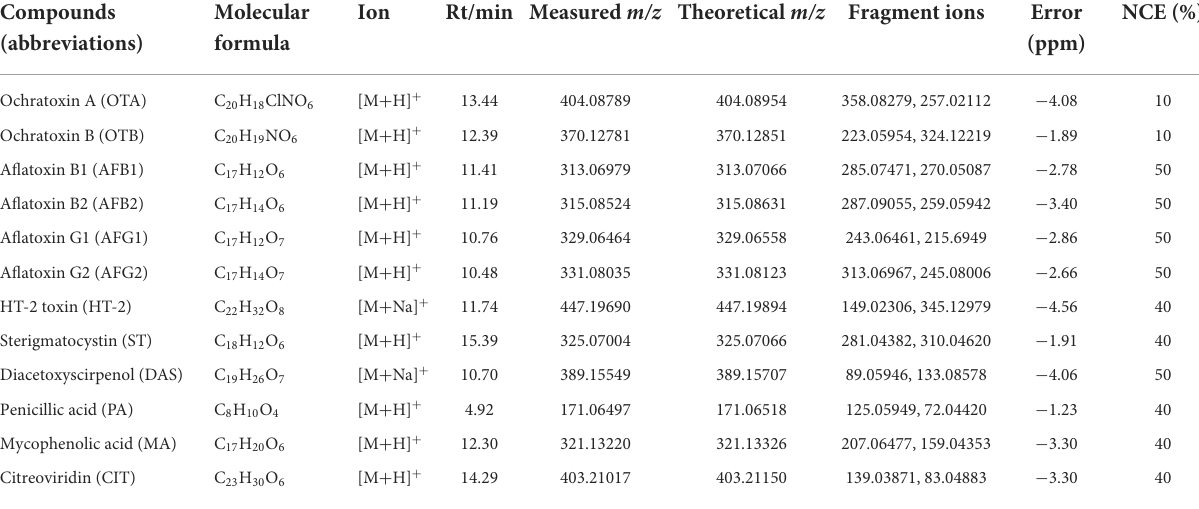
TABLE 2 HPLC and Orbitrap HRMS parameters of 12